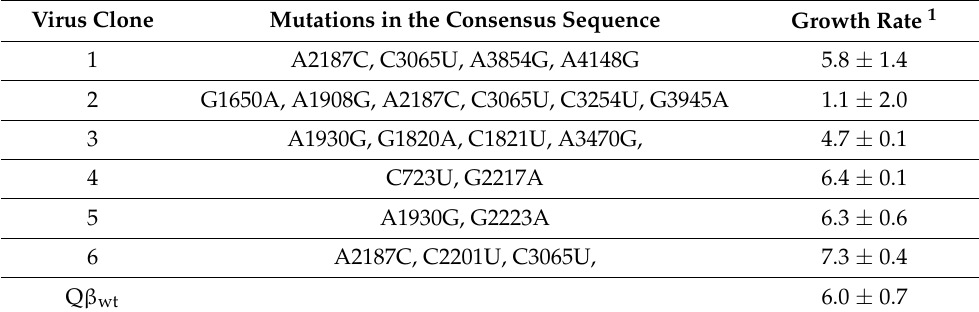
Table 3. Growth rate values (43 ◦ C) and mutations present in the consensus sequences of virus Q β wt and the biological clones isolated from population Q β